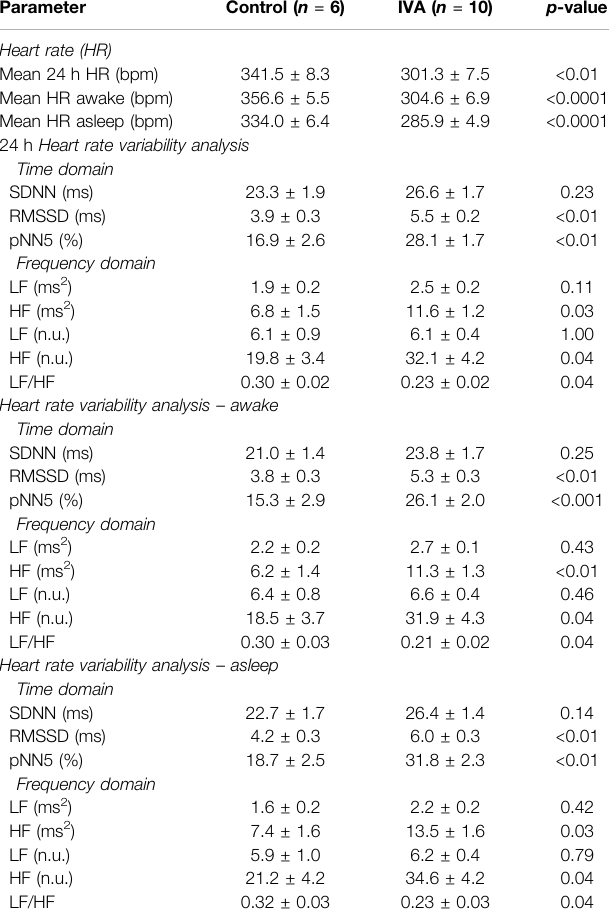
TABLE1| Mean24 hheartrateandheartratevariabilityparametersinivabradine- treated (IVA) and non-treated (Control) rats.